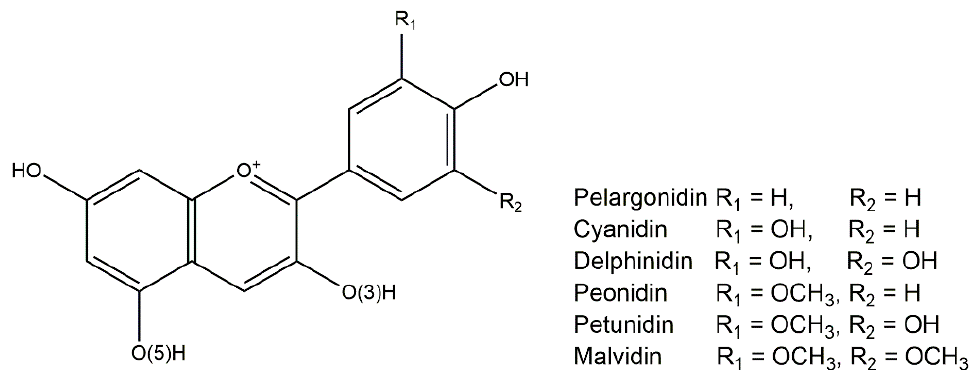
Figure 1. Structures of the six more common anthocyanidins. Positions 3 and 5, where glycosylation takes place, are indicated.